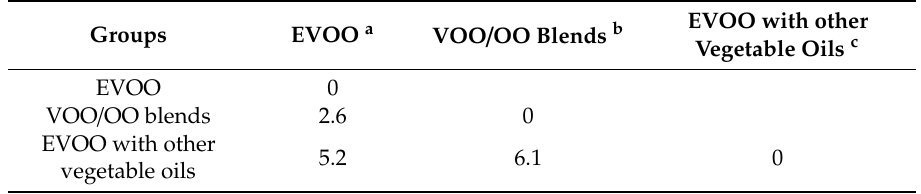
Figure 2. ( a ) Soft independent modeling of class analogy (SIMCA) 3D projection plots of spectral data for olive oil samples collected by ( a ) portable FT-IR and ( b ) compact benchtop Raman spectrometers. EVOO: Extra virgin olive oil, VOO/OO: Blend of virgin olive oil and olive oil. ( c ) SIMCA discriminating plot based on the mid-infrared and Raman spectra of olive oils using an FT-IR and a Raman spectrometer, showing bands and regions responsible for class separation. Table 2. Interclass distances between three classes of olive oils based on the SIMCA class projections for the FT-IR spectra collected in the 700–4000 cm − 1 region. Groups EVOO a